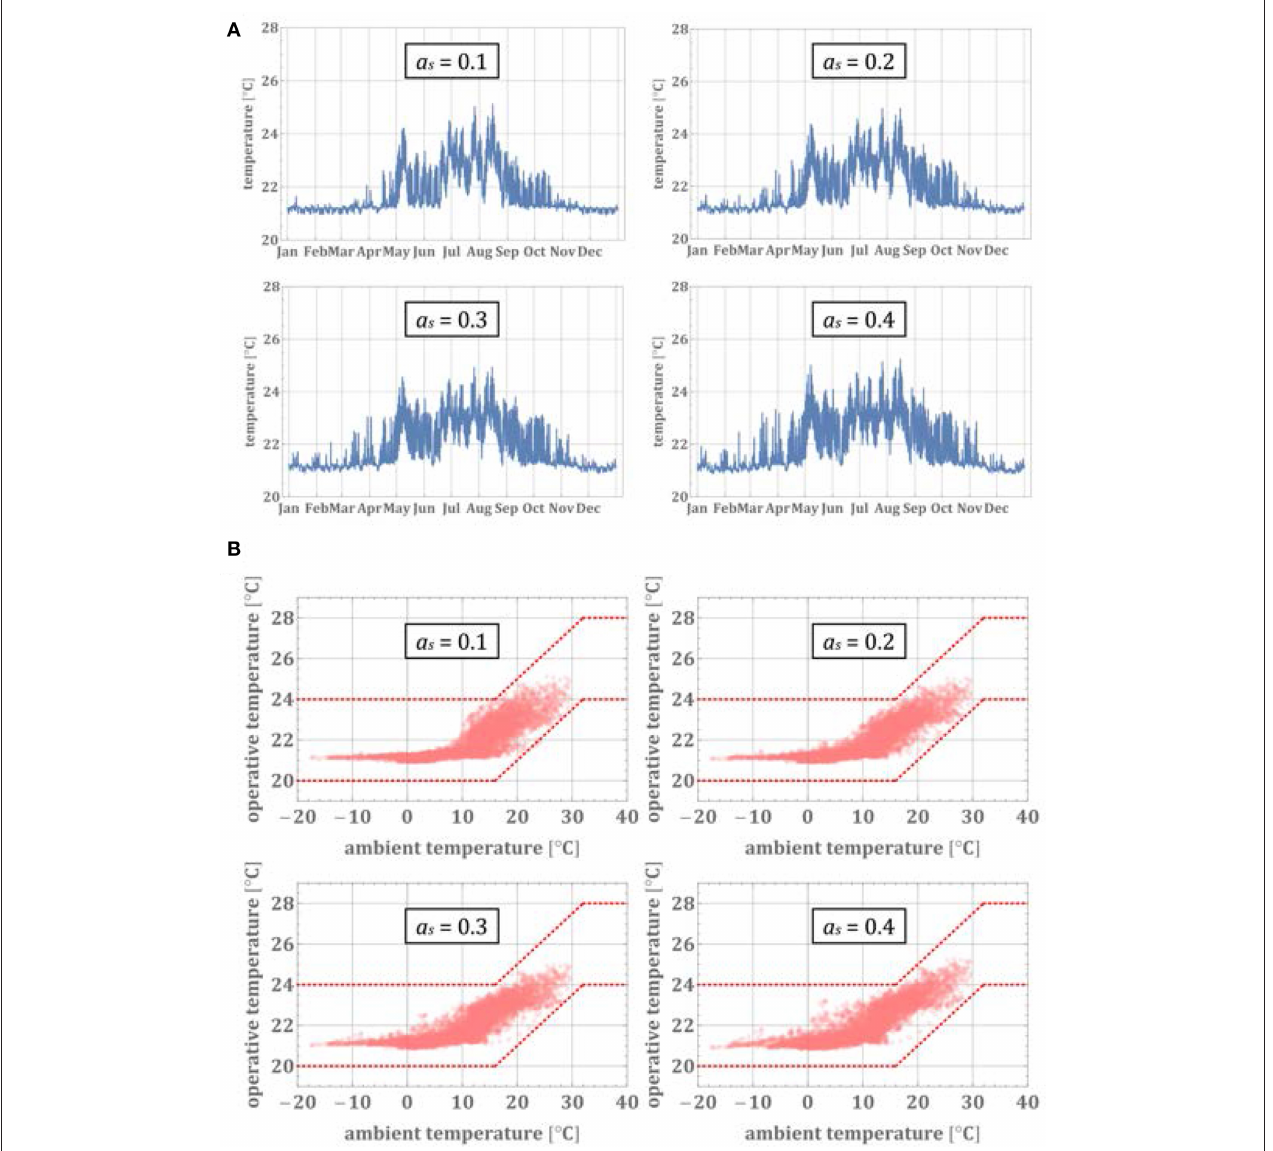
Table 2 . We used the 2017 test reference year data for